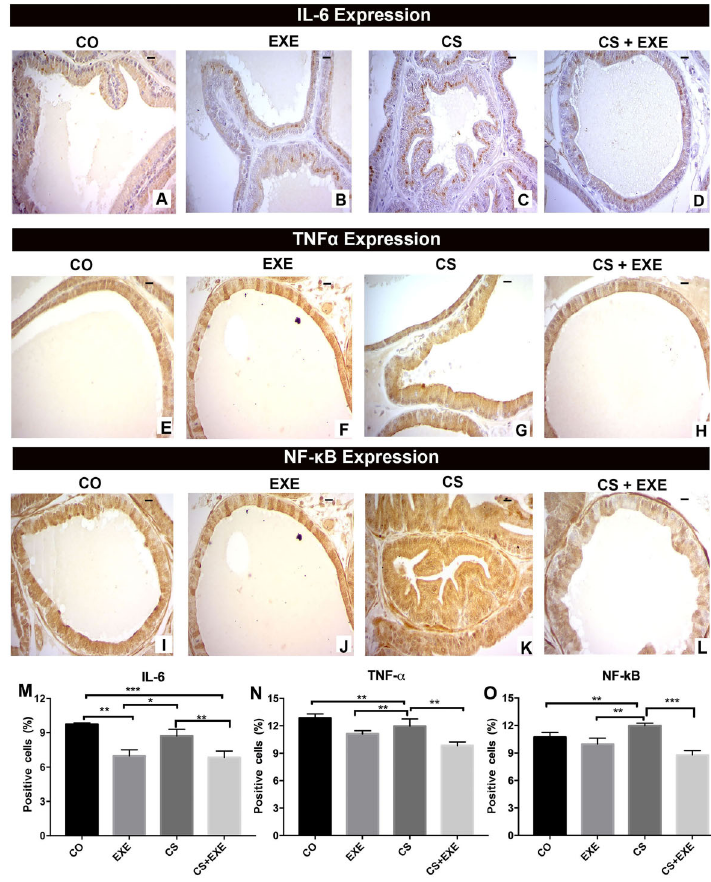
Figure 5. Distribution of interleukin (IL)-6, tumor necrosis factor-alpha (TNF- a ), and nuclear factor- kappa B (NF- k B) protein in the ventral prostate of Wistar rats submitted to cigarette smoke inhalation and exercise as evaluated using immunohisto- chemistry [control (CO) n=10; cigarette smoke inhalation (CS) n=8; exercise (EXE) n=10; cigar- ette smoke inhalation + exercise (CS + EXE) n= 10]. Representative images of IL-6, TNF- a , and NF- k B are shown in images A to D , E to H , and I to L , respectively. Scale bars, 20 m m. Graphs M , N , and O show the quanti fi cation of positive prostate cells for IL-6, TNF- a , and NF- k B, respectively. Data are reported as mean percentages of protein- positive tissue surface area ± SD. *P o 0.05; **P o 0.01, ***P o 0.001, one-way ANOVA with Tukey ’ s multiple comparisons post hoc